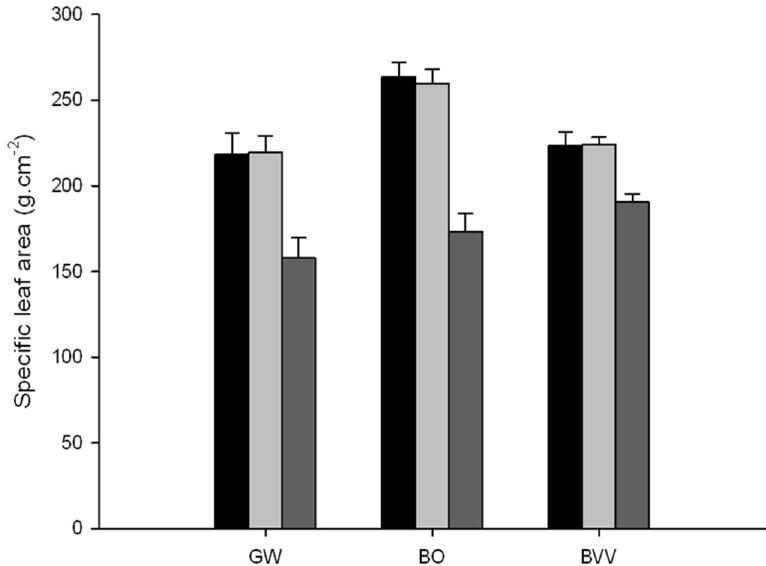
Figure 3. Average specific leaf area (SLA) by species and by treatment plot; Gigantochloa wrayii (GW) , Bambusa oldhamii (BO) , Bambusa vulgaris (BVV). For each bamboo species: raw slurry, centrifuged slurry and control, from left to right.